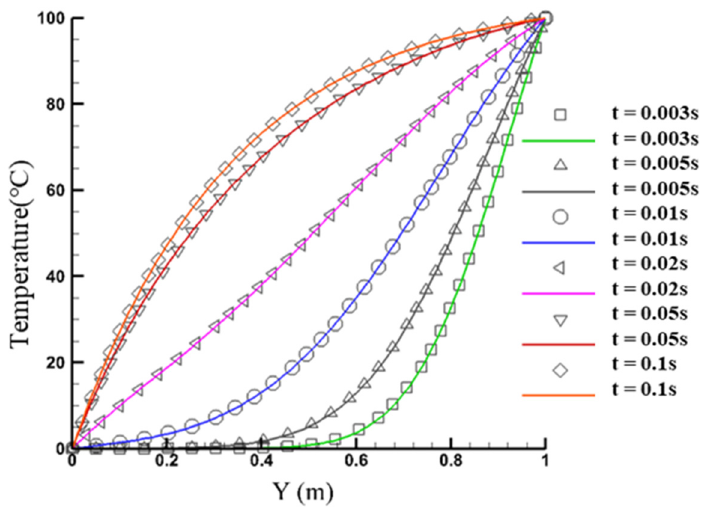
Figure 12. Numerical and analytical solutions of the temperature distribution along the y direction inside the FGM plate at different times.